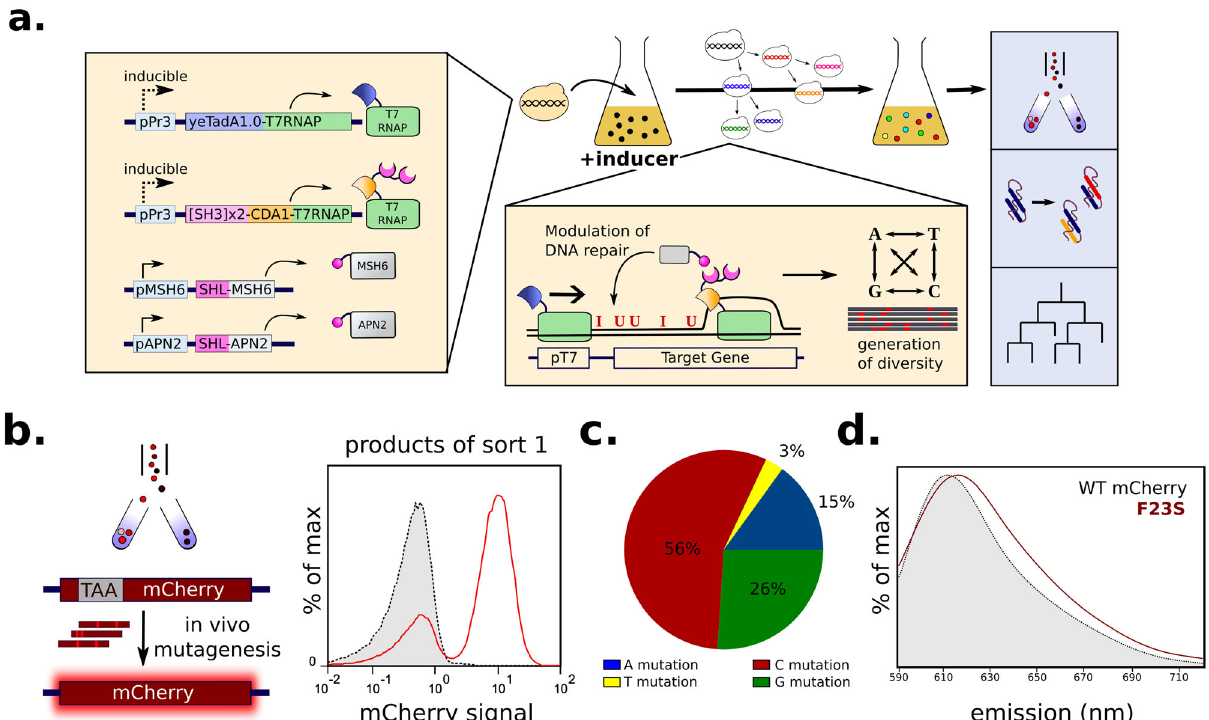
Fig. 4 Overview and application of TRIDENT to protein evolution challenges. a Schematic of primary modi fi cations made in the most advanced TRIDENT strain platform, YHM6 (left). When YHM6 is grown with mutagenesis inducer, in vivo mutagenesis creates a library of variants for applications including cell sorting, protein engineering, or lineage tracing (right). b TRIDENT applied to a cell sorting application in which a TAA stop codon in mCherry is corrected with in vivo mutagenesis and mCherry-positive cells are collected by FACS (left). Strain YHM6.mCherry.TAA was grown with 10 nM β -estradiol for 16 h and mCherry-positive cells were sorted once yielding a 0.14% mCherry-positive population. The mCherry-positive post-sort population (red) was reanalyzed demonstrating correction of the stop codon. The non- fl uorescent presort population of YHM6.mCherry.TAA cells is shown for comparison (gray). c YHM6 generates mutations at all four nucleotides on a plasmid-based copy of mCherry (pCS4335) with P T7 upstream for mutational targeting. YHM6 + pCS4335 was grown with 10 nM β -estradiol for 16 h and plated. Ninety-eight presort single colonies were picked and mCherry sequenced off the plasmid in order to calculate the fraction of base substitutions occurring at each base of mCherry. d TRIDENT can be applied to evolve more complex protein properties such as spectral properties of a fl uorescent protein. TRIDENT-evolved mCherry variant, mCherry-F23S, is red-shifted by 5 nm. The emission spectra of evolved mCherry red-shift mutant (pCS4338) compared to wild-type mCherry (pCS4337) expressed from E. coli , was measured